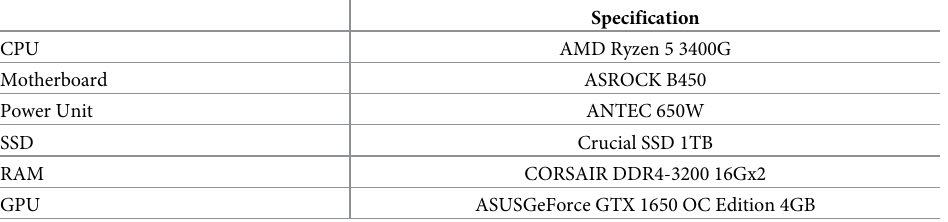
Table 1. Specification details of parts used for submerging. CPU: central processing unit, SSD: solid state drive, RAM: random access memory, GPU: graphics processing unit.